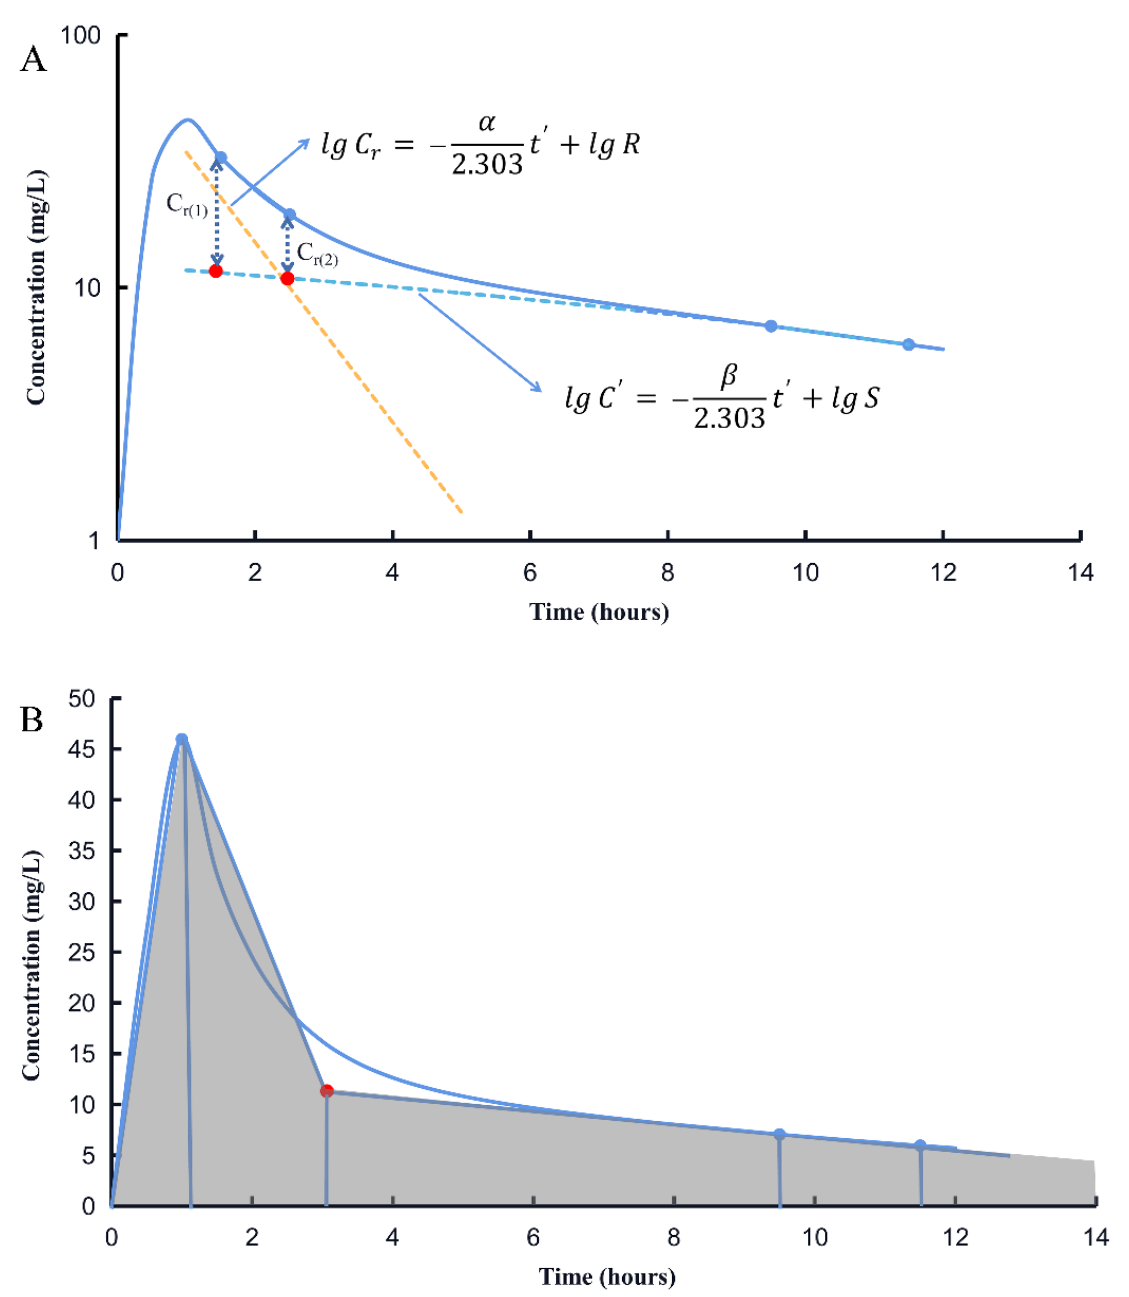
Figure 1. Simulated vancomycin plasma concentration–time profile of a typical patient after 1000 mg intravenous infusion over 60 min fitted to two-compartment PK model. ( A ) Estimation of PK parameters with Method 1 (a mathematical approach using method of residuals). ( B ) Extrapolation of the fourth concentration (red solid circle) using terminal elimination phase and calculation AUC based on linear-trapezoidal rule (sum of shadowed area). The blue points on the curve represent the concentrations at corresponding time.